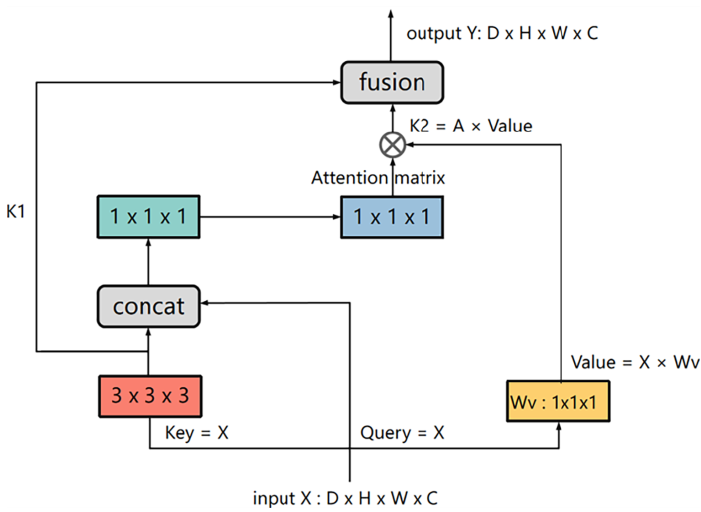
Figure 3. Contextual Transformer block (CoT-Block), a novel attention structure [23].